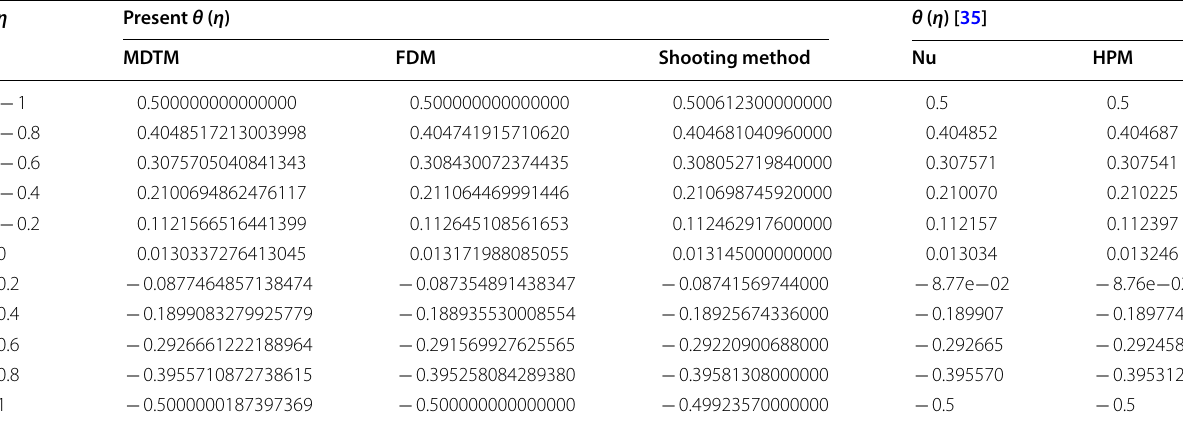
Table 6 Comparison solution by MDTM, FDM, and shooting method with Nu and HPM [35] for θ ( η ) when ϕ Ha 0, 1 R 0, Ec 1, Pr 6.2, and α d = = = =